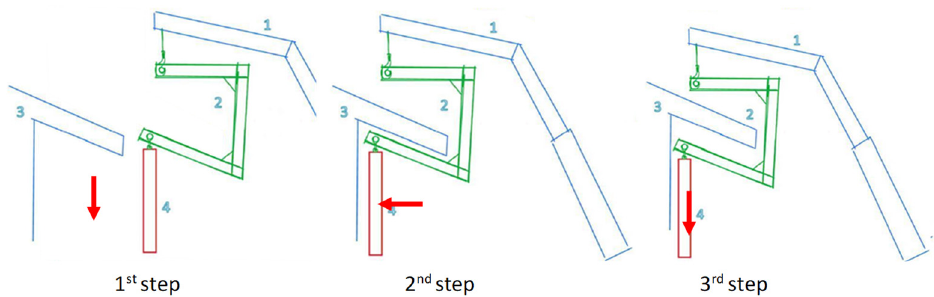
Figure 16. Assembly steps fastening system meeting with sloping roof.